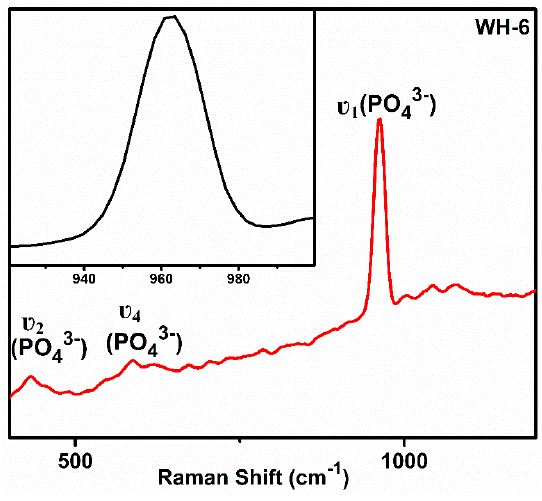
Figure 7. Raman spectrum of WH-6 product.